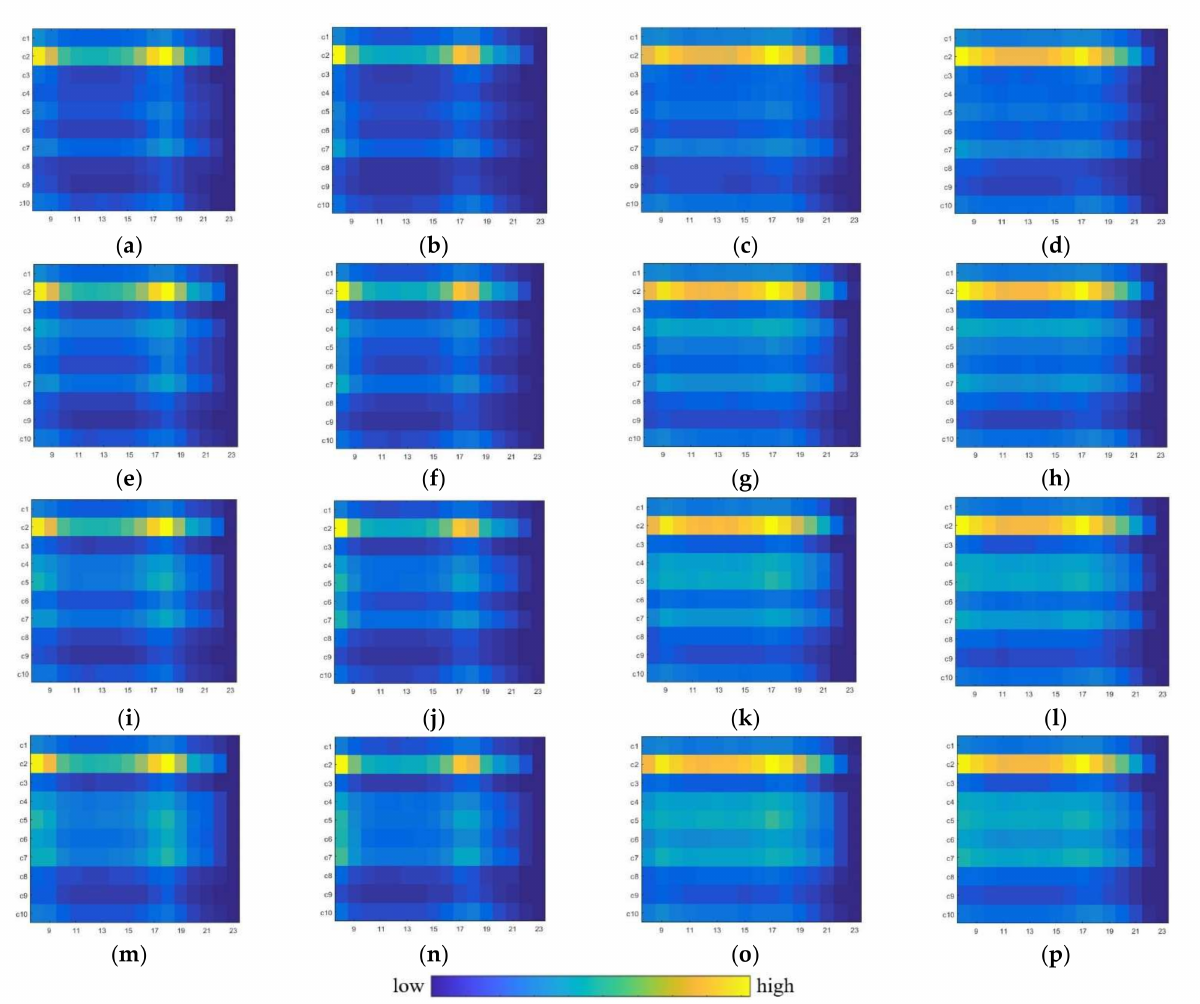
Figure 6. Arriving/leaving transition matrices. ( a ) arriving, C3, weekday; ( b ) leaving, c3, weekday; ( c ) arriving, c3, weekend; ( d ) leaving, c3, weekend; ( e ) arriving, c4, weekday; ( f ) leaving, c4, weekday; ( g ) arriving, c4, weekend; ( h ) leaving, c4, weekend; ( i ) arriving, c5, weekday; ( j ) leaving, c5, weekday; ( k ) arriving, c5, weekend; ( l ) leaving, c5, weekend; ( m ) arriving, c6, weekday; ( n ) leaving, c6, weekday; ( o ) arriving, c6, weekend; ( p ) leaving, c6, weekend. Horizontal axis: the time over the day from